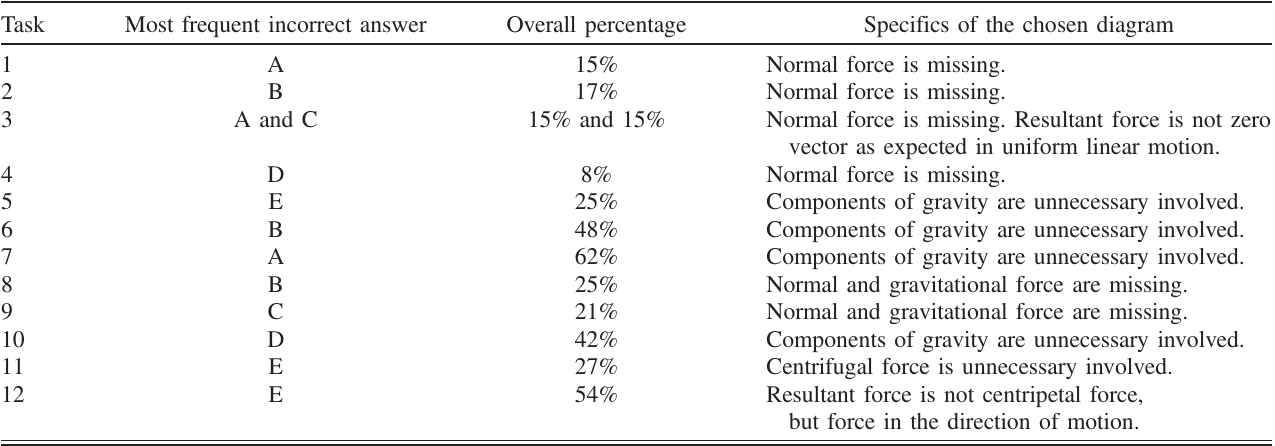
TABLE IV. The most frequently chosen incorrect answers in the pretest ( N ¼ 52 ), the corresponding percentages and specifics.